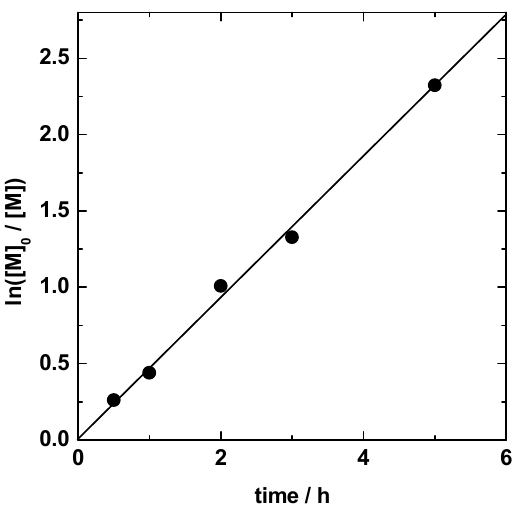
Figure 2. Plot of ln([ M ] 0 /[ M ]) vs. t for the solution polymerization of N , N -diethyl- N -(2-methacryloylethyl)- N -methylammonium bis(trifluoromethylsulfonyl)-imide (DEMM-TFSI, 70 wt %) in acetonitrile at 70 °C: [DEMM-TFSI] 0 /[ethyl 2-bromoisobutyrate] 0 /[Cu(I)Cl] 0 /[Cu(II)Cl 2 ] 0 /[2,2 ′ -bipyridine] 0 = 1000/1/4.5/0.5/10.